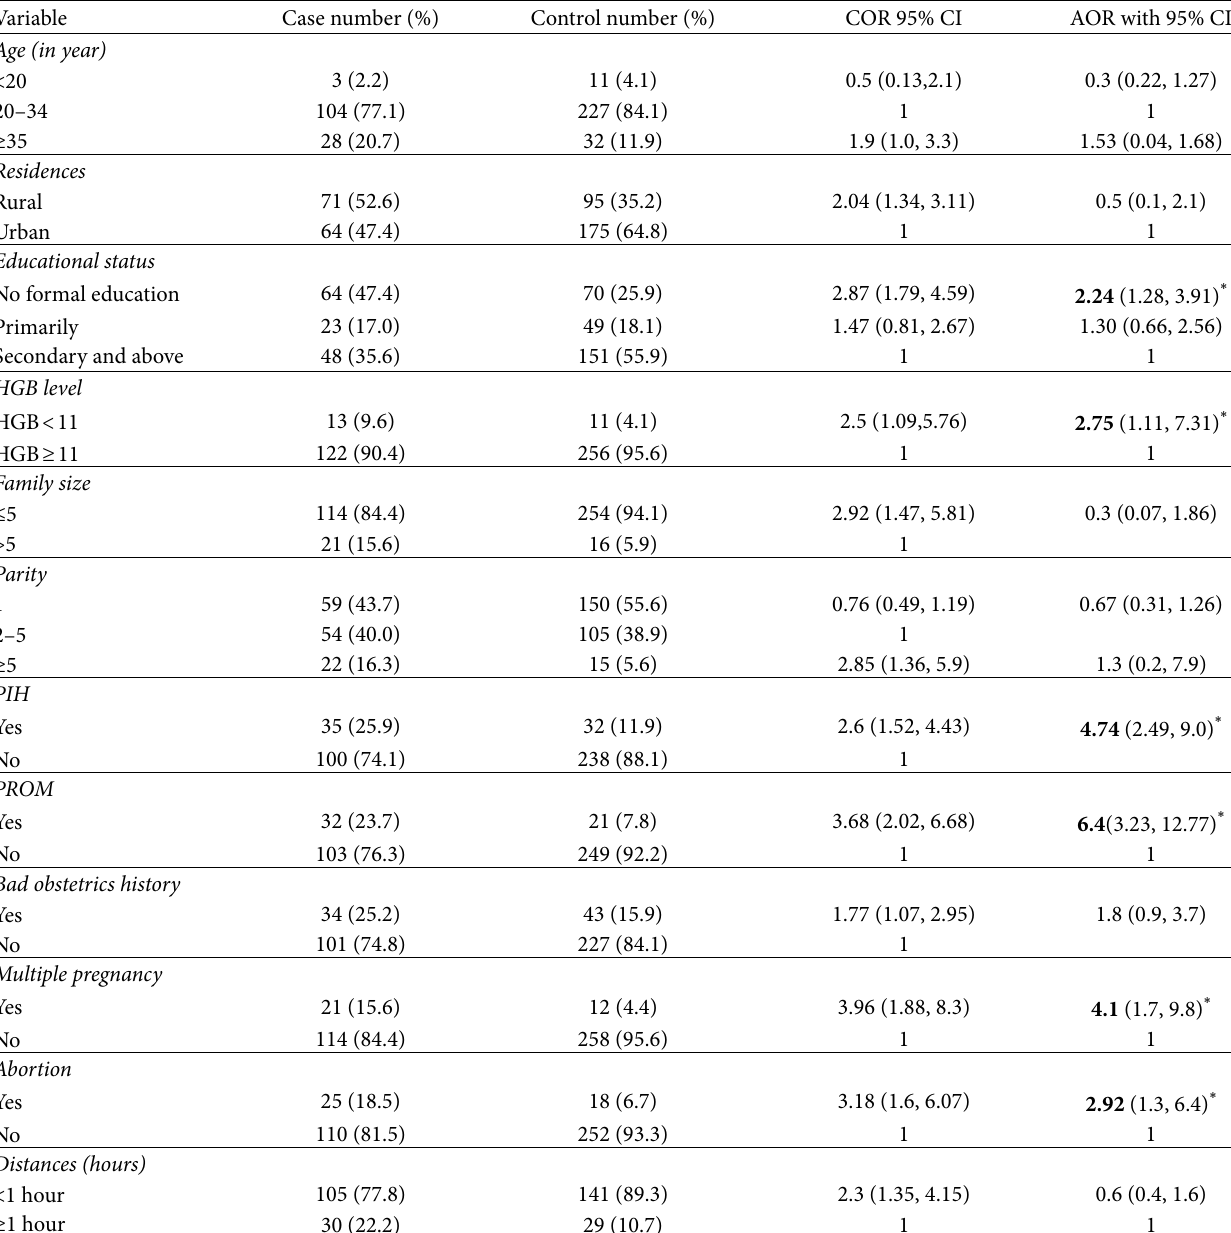
Table 3: Determinants of preterm birth among mothers who gave birth in Amhara referral hospitals, Northwest Ethiopia, 2019 ( 𝑛 = 405